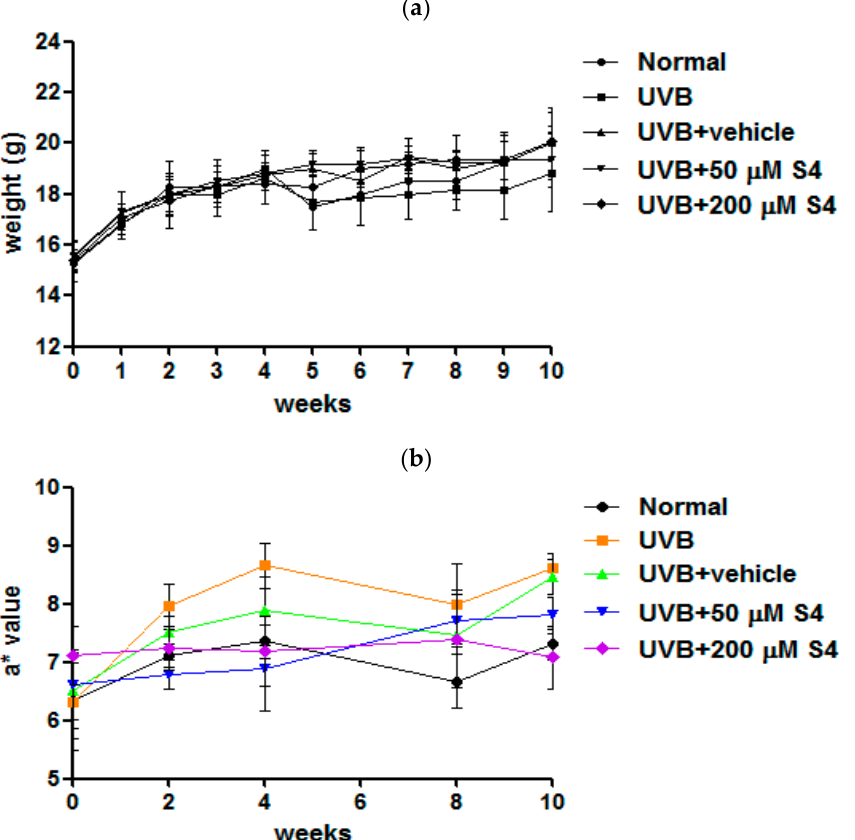
Figure 9. ( a ) Body weight of hairless mice over 10 weeks. ( b ) Effect of S4 on a* value in chronic UVB-irradiation hairless mice.